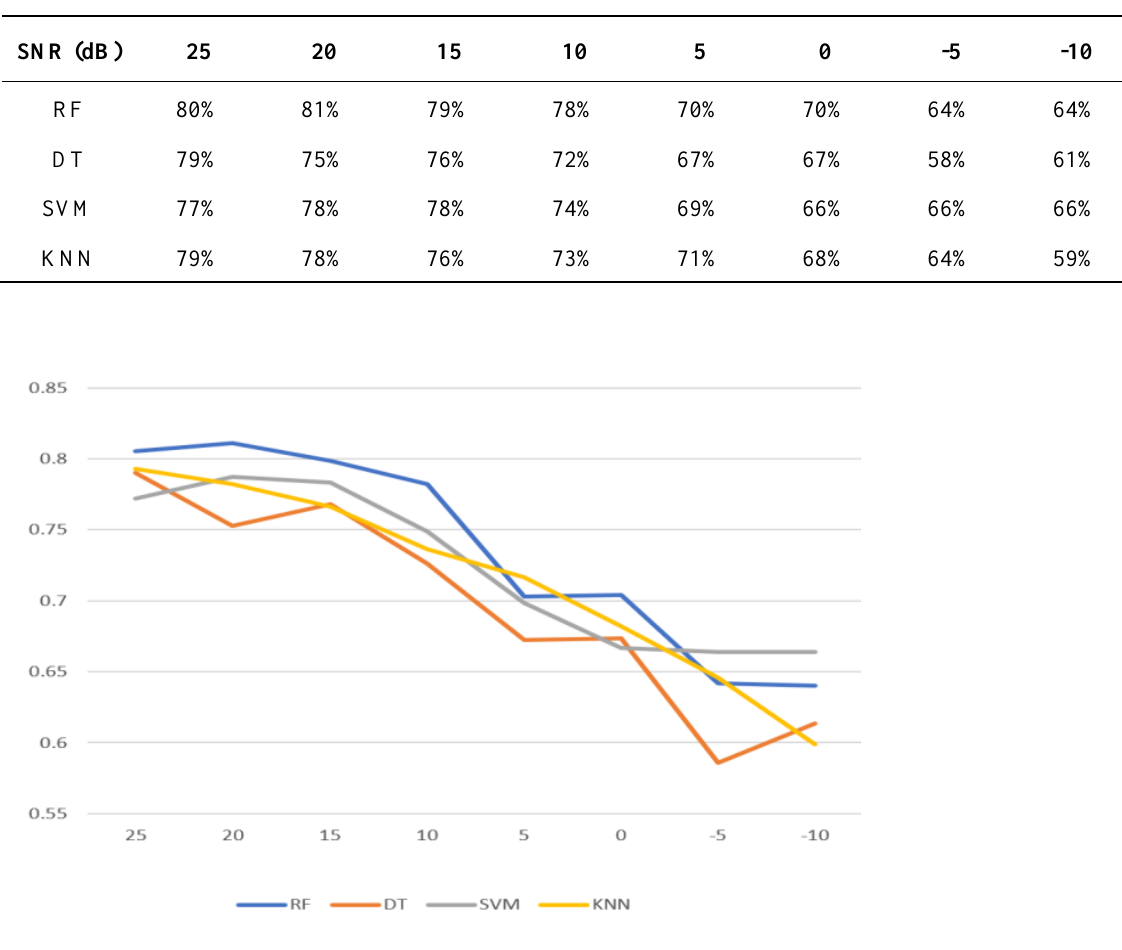
Table 1. The Accuracy of each Classification Method in Its Signal Noise Ratio (Just the amplitude of each complex number is considered.)